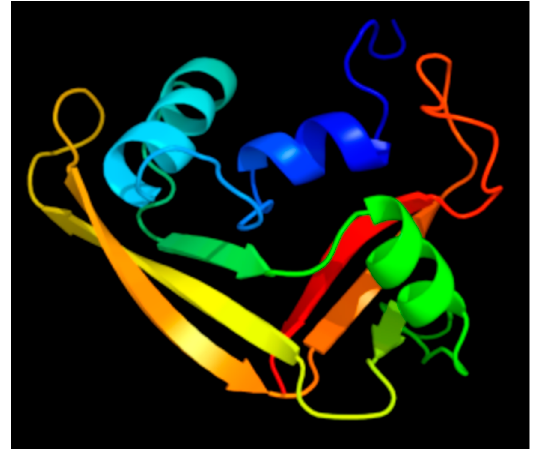
Figure 1. Predicted solution structure of RNase 7 colored by rainbow spectrum. The N-terminus is depicted by the blue color and the C-terminus is depicted by the red color. Figure adapted from [20,21].